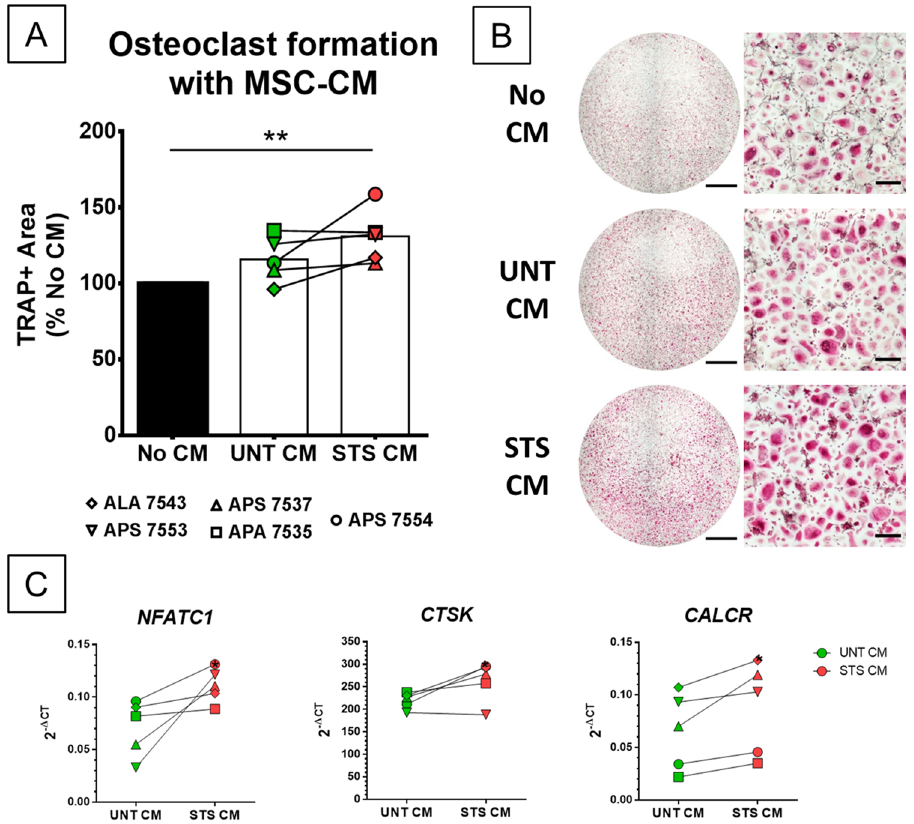
Figure 3. CM from STS-treated MSCs exhibit pro-osteoclastogenic properties. ( A ) Quantification by image analysis of TRAP+ area after 8 days of osteoclast differentiation with UNT or STS CM from five MSC donors with two or three CD14+ donors, normalized to the TRAP+ area without CM. N = 5 values averaged from 2 or 3 independent experiments with different CD14+ cells with technical triplicate. Statistical analysis by repeated measure ANOVA followed by Tukey’s multiple comparison test, ** for p value < 0.01 ( B ) Full well (scale bar = 2 mm) and close-up (scale bar = 200 µm) images of TRAP-stained osteoclasts at 8 days of differentiation without CM, with UNT-CM and STS-CM. (C) Comparative expression of differentiation markers in osteoclasts treated with UNT or STS-CM from five MSC donors. N = 5 independent experiments with technical triplicate. Statistical analysis by one-sided paired t-test, * for p value <